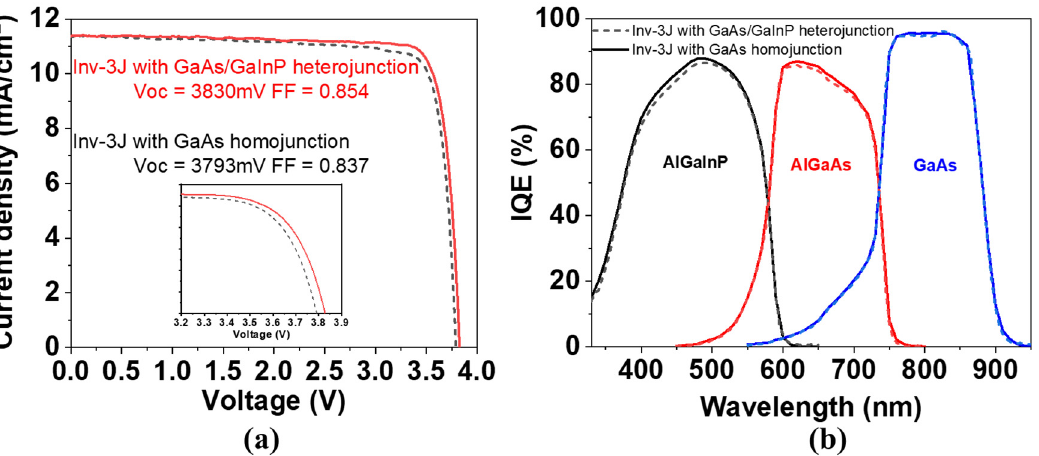
Figure 8. Light J–V curves ( a ) and IQE curves ( b ) of inverted T-3J solar cell with varied GaAs sub- cell structures. GaAs sub-cell with GaAs/GaInP heterojunction structure (solid line) shows better performance than that with GaAs homojunction structure (dashed line).